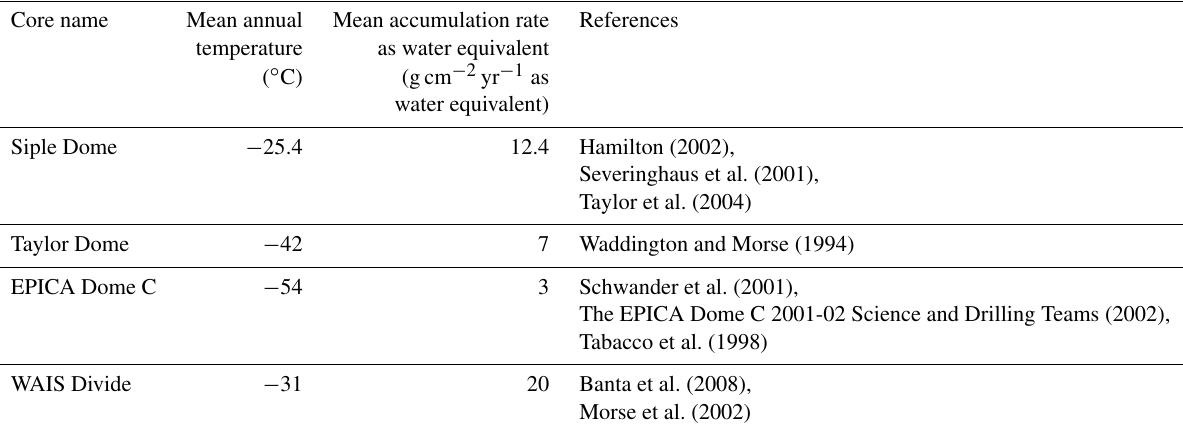
Table 1. Glaciological characteristics of Antarctic ice